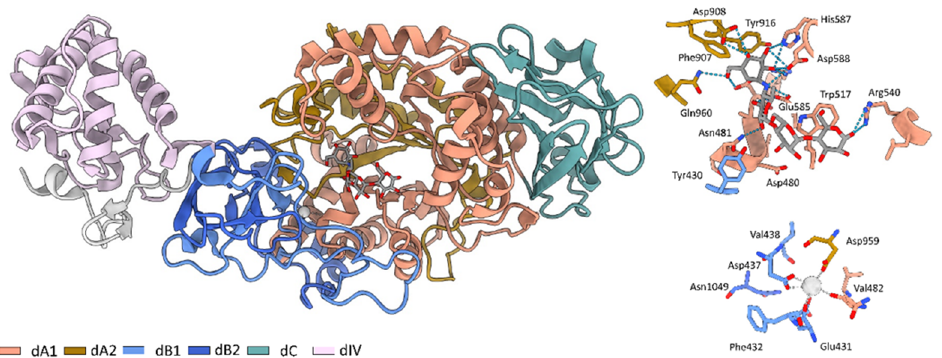
Figure 1. Structure of S. mutans glycosyltransferase (PDB: 3AIC), showing all the four domains (A, B, C and IV). Insets represents the molecular co-ordination of calcium ion (grey sphere) and acarbose (grey sticks). Hydrogen bonds between acarbose and the surrounding amino acids are presented as blue dashed lines.